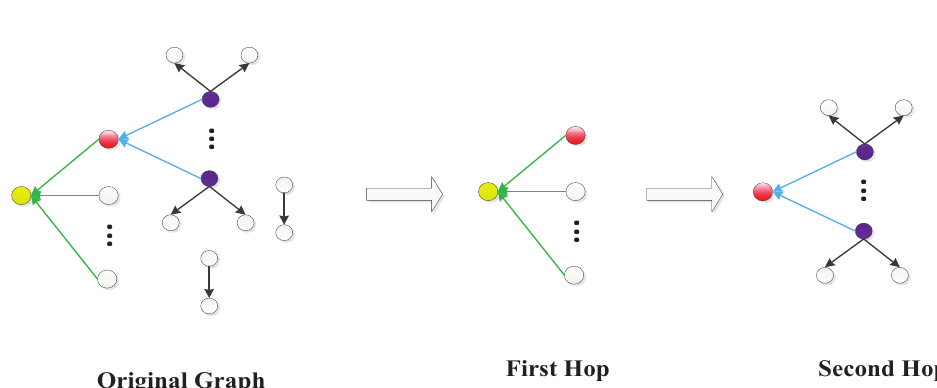
Figure 1. Sketch of an exemplar of multi-hop question answering based on knowledge graph. In the figure, arrows with different colors represent the relations in two hops that need to be extracted in order to obtain the reasoning path to the query, and colored dots represent the entities related to the question in knowledge